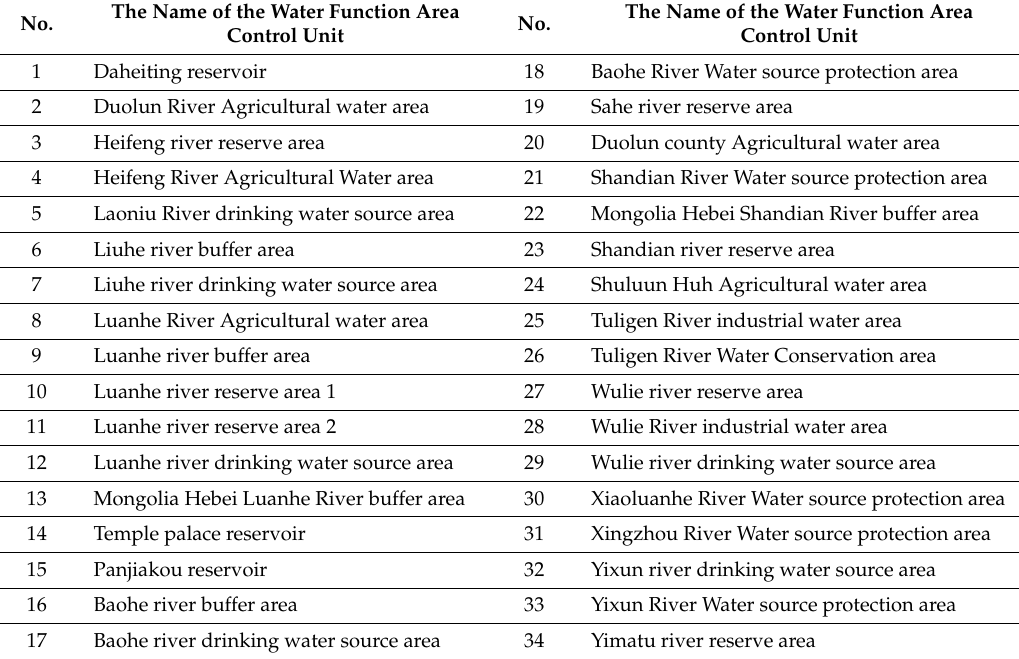
Table 1. Water function area control unit name.